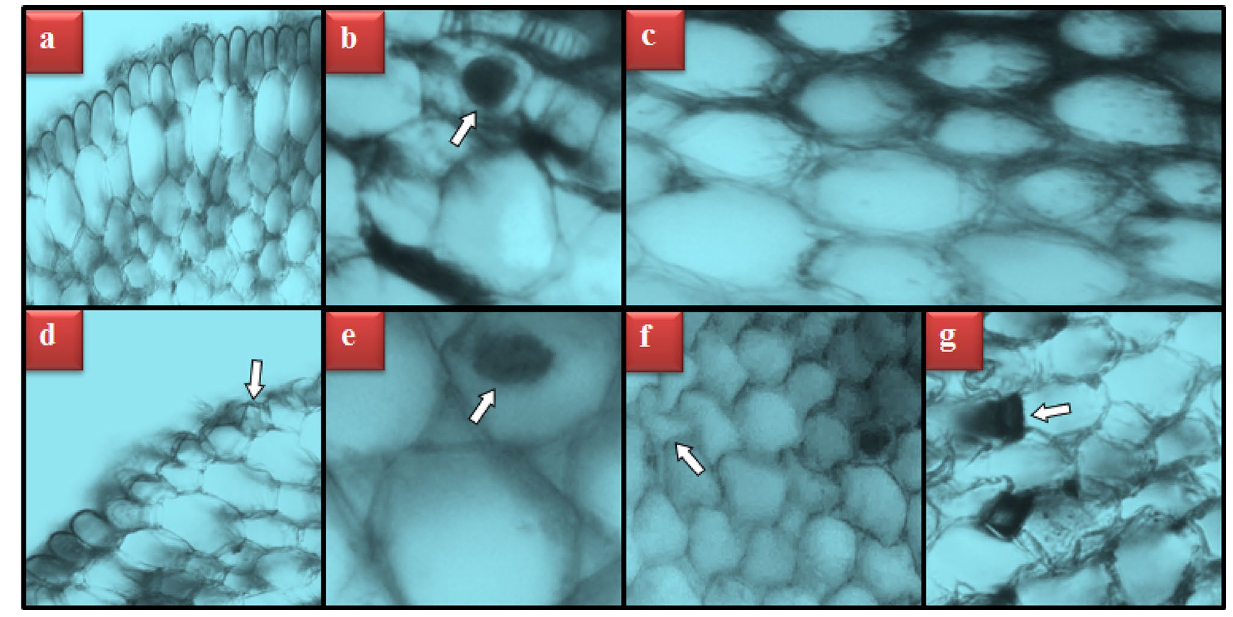
Figure 3. Meristematic cell damages induced by Trifoxystrobin. Appearance of healthy epidermis cells ( a ), appearance of healthy cell nucleus (oval) ( b ), appearance of healthy cortex cells ( c ), damaged epidermis cells ( d ), flattened cell nucleus ( e ), damaged cortex cells ( f ), thickness in cortex cell wall ( g